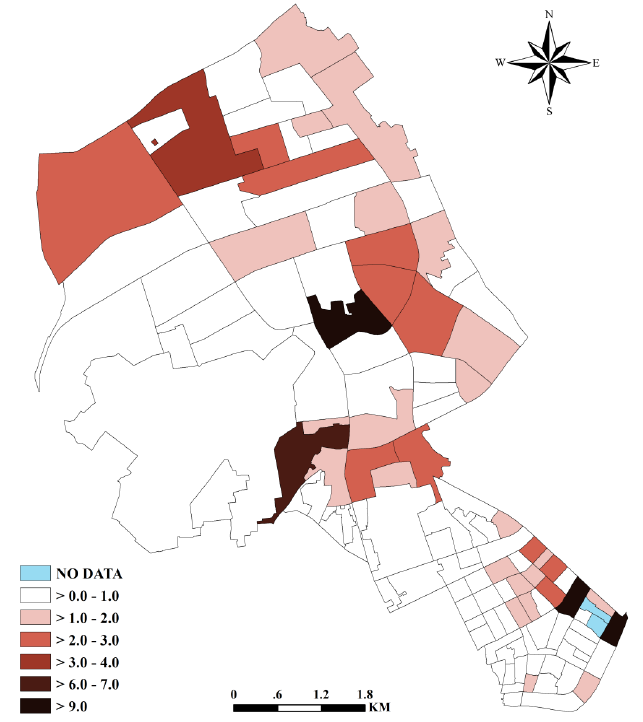
Figure 3. Map of burglary risks estimated by the spatial Poisson model.